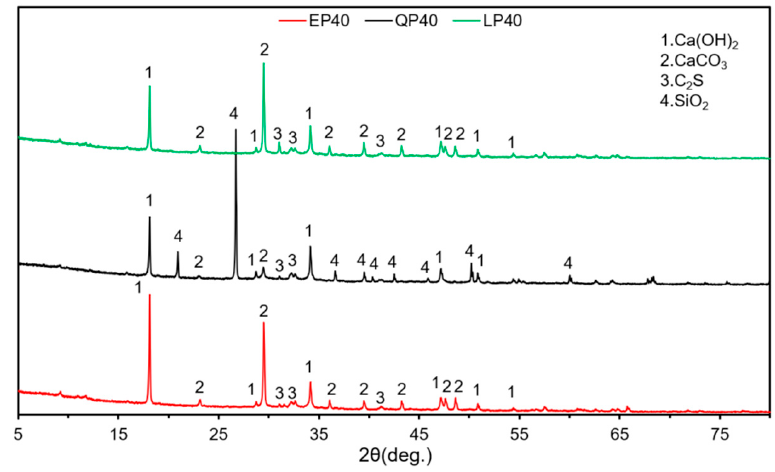
Figure 12. X-ray diffraction (XRD) analysis of EP40, QP40 and LP40 at 7 d.